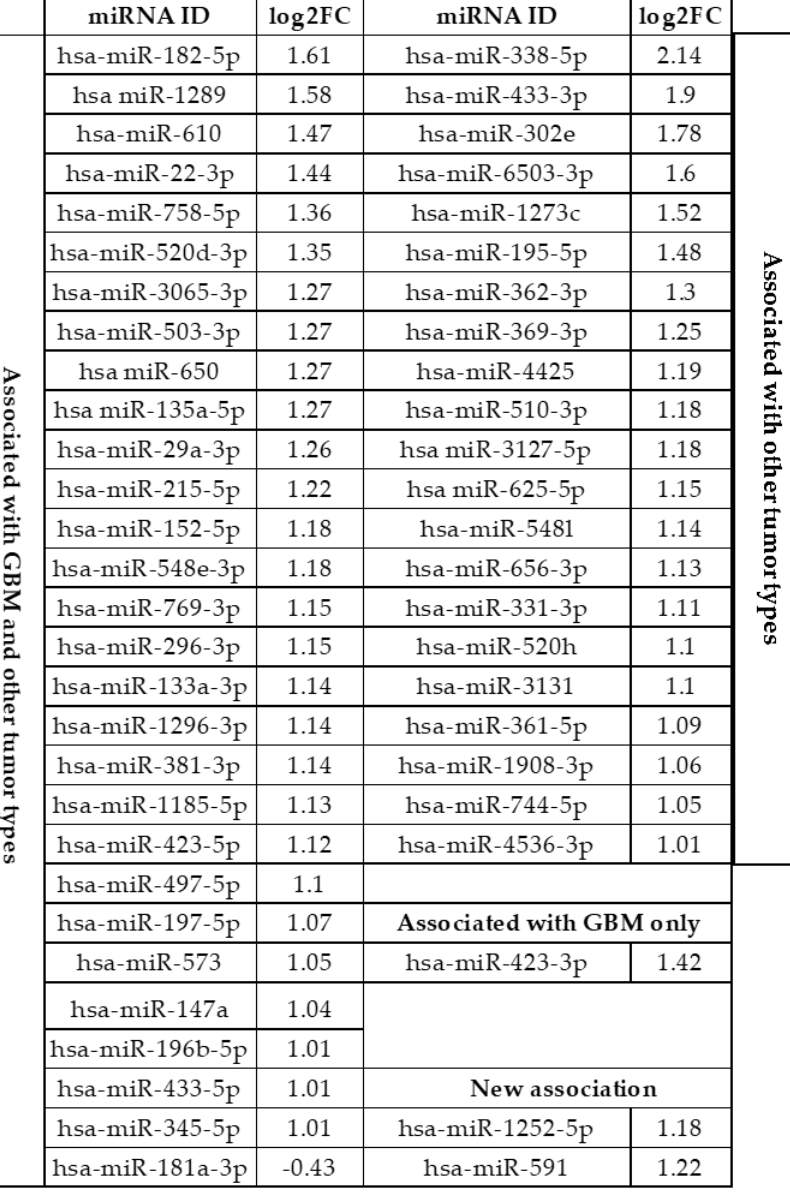
Table 1. List of miRNAs with significantly different plasma levels in GPs and HIs, listed according to their expression levels (log 2 FC) and showing their involvement in the formation of tumor types according to a manual search of the literature and the miR2Disease and miRCancer databases.